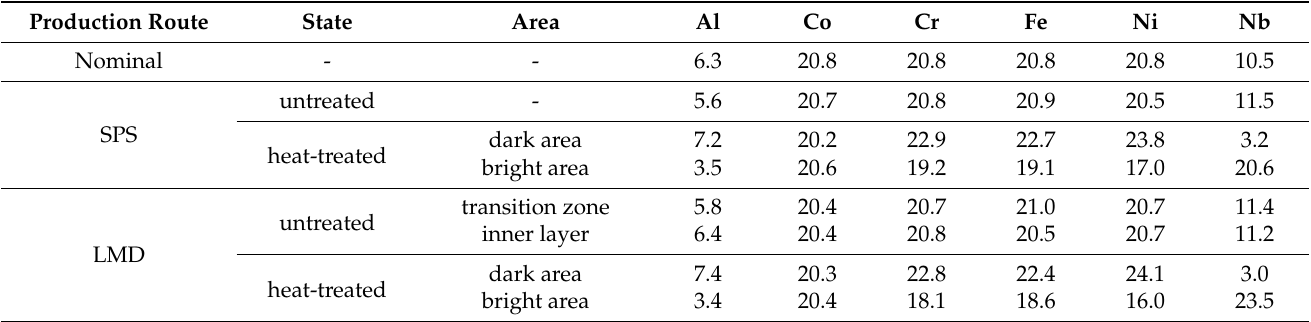
Table 3. The chemical composition of the untreated and heat-treated EHEA Al 0.3 CoCrFeNiNb 0.5 in at.% detected by